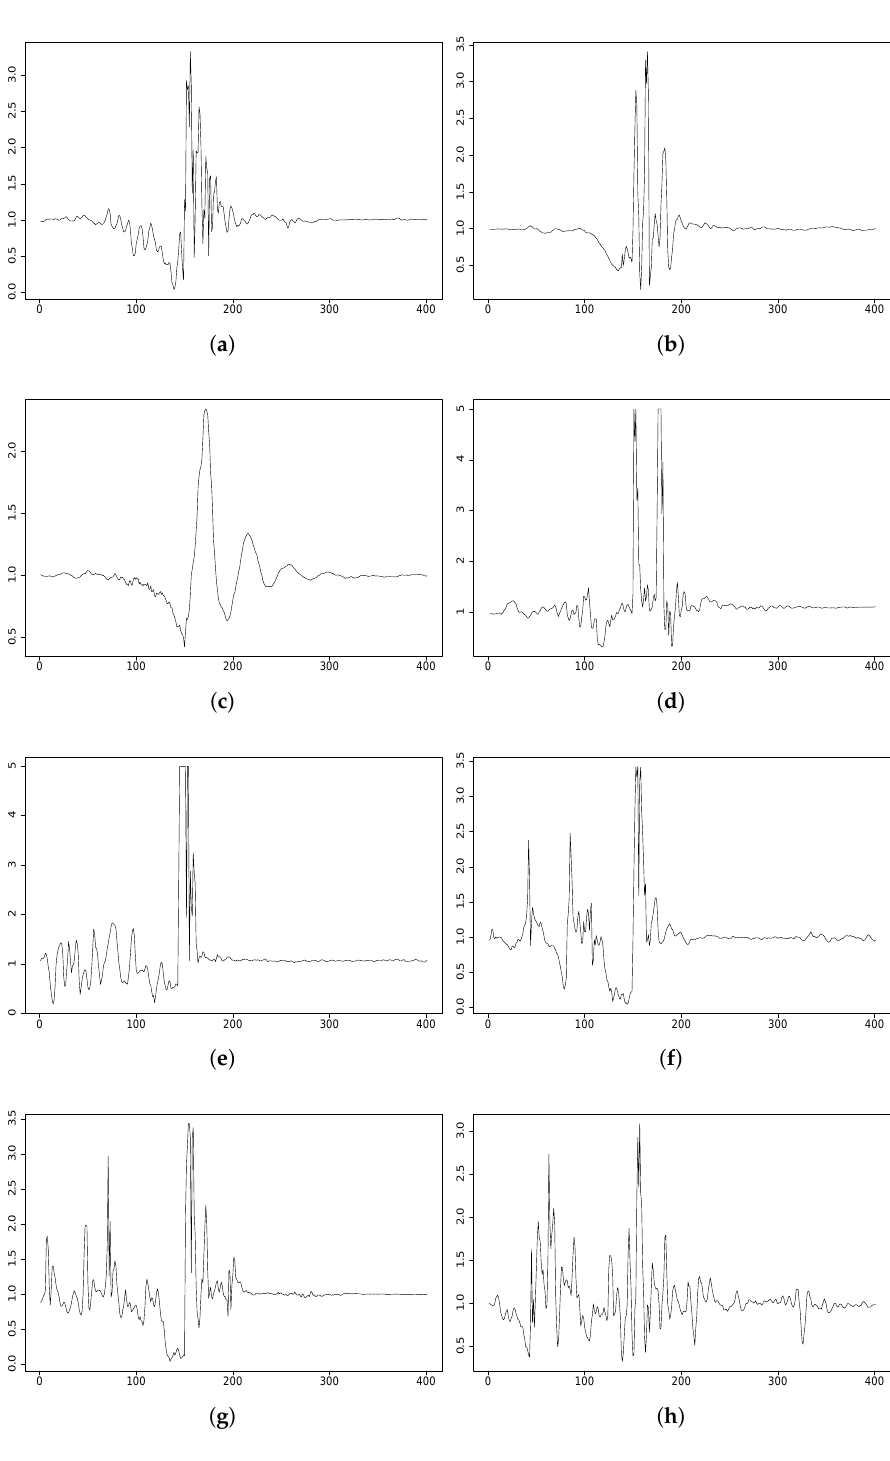
Figure 5. FARSEEING plots of some falls depicting the magnitude of the acceleration during a fall; 400 samples in 4 s. From left to right and top to bottom: F1, F2, F3, F4, F5, F6, F7 and F8. F3 shows a peak below 3 × g . In all the cases, the sensor is located on the lower back. ( a ) F1: backward fall, 3DACC ∈ [ 0.0,3.5 ] × g . ( b ) F2: forward fall, 3DACC ∈ [ 0.0,3.5 ] × g . ( c ) F3: forward fall, 3DACC ∈ [ 0.0,3.0 ] × g . ( d ) F4: forward fall, 3DACC ∈ [ 0.0,5.2 ] × g . ( e ) F5: forward fall, 3DACC ∈ [ 0.0,5.2 ] × g . ( f ) F6: backward fall, 3DACC ∈ [ 0.0,3.6 ] × g . ( g ) F7: backward fall, 3DACC ∈ [ 0.0,3.6 ] × g . ( h ) F8: unknown direction, 3DACC ∈ [ 0.0,3.3 ] × g